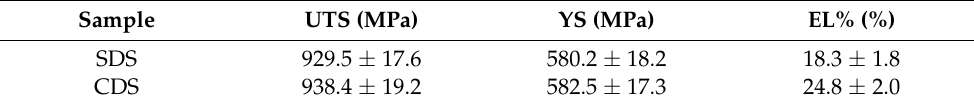
Table 1. Tensile properties of specimens under different processing